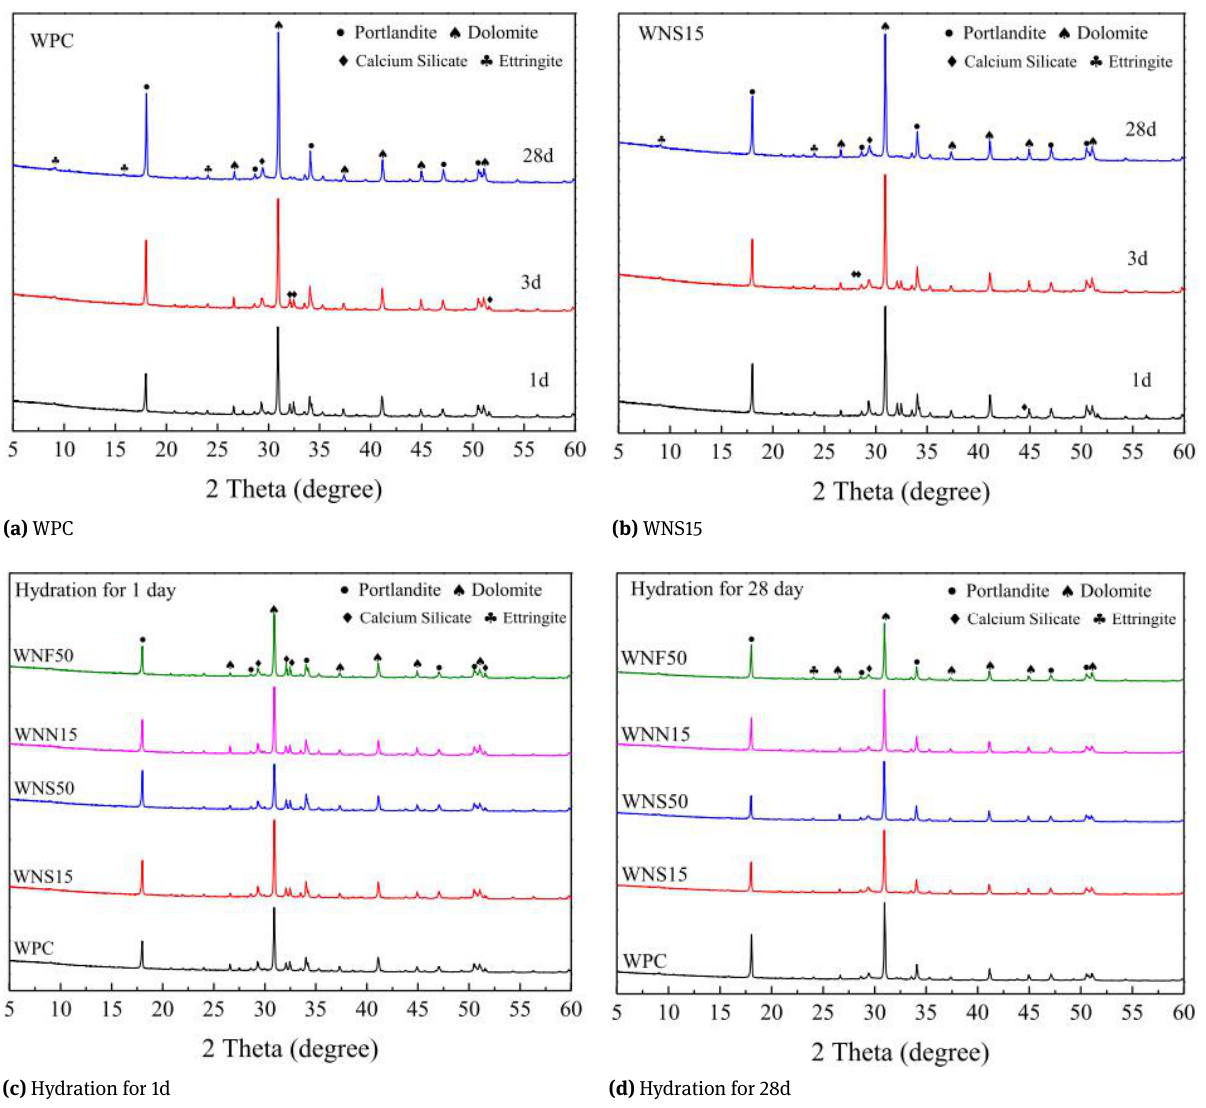
Figure 8: XRD patterns